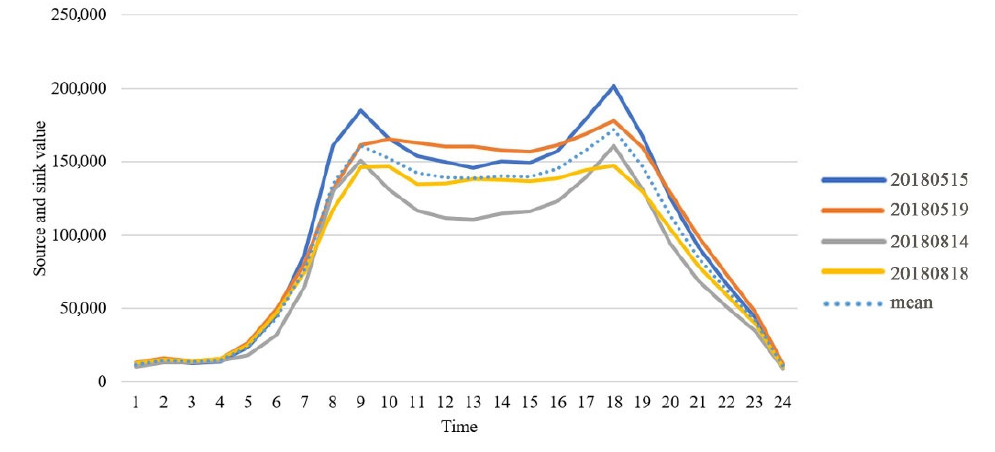
Figure 2. 24 h population source-sink changes.